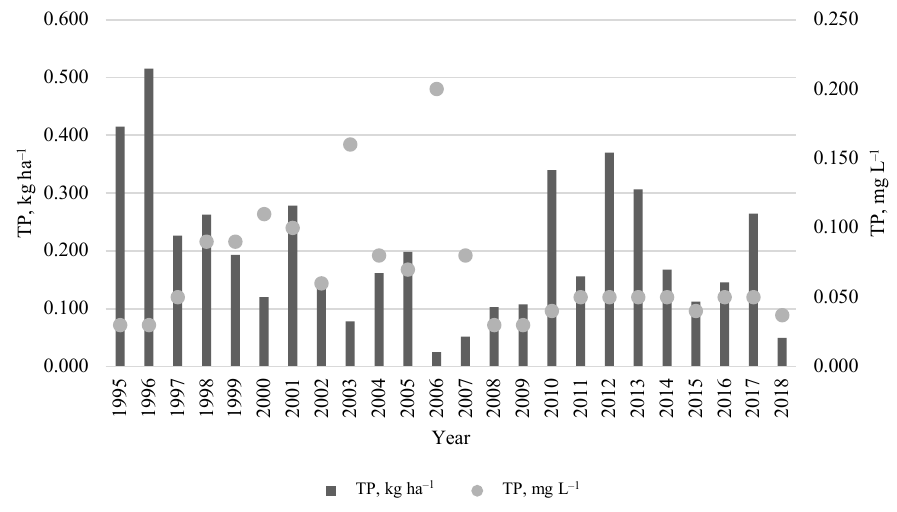
Fig. 5. Annual losses (kg ha –1 ) and concentrations (mg L –1 ) of total phosphorus (TP) in the Mellupite small catchment. TP has higher losses in the Mellupite subsurface drainage field scale than in the small catchment scale, although mean annual concentrations are relatively similar (Fig. 4). That indicates that the drainage field scale is more sensitive to changes in the annual mean